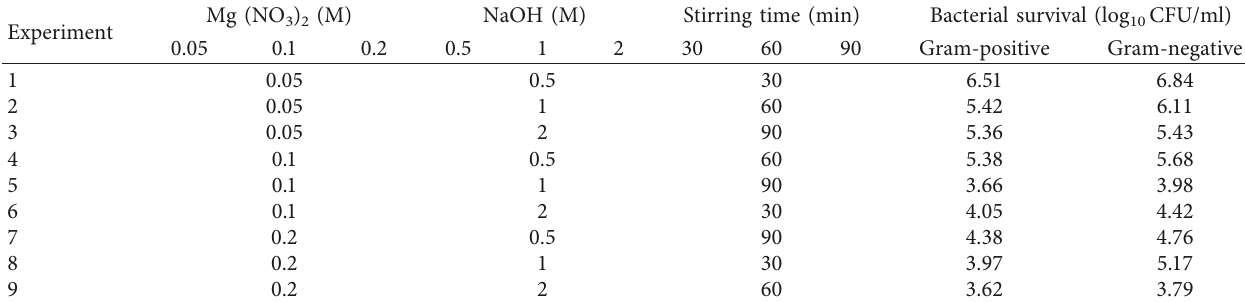
Table 1: Taguchi design of experiments and antibacterial effect of manufactured MgO nanoparticles. Experiment